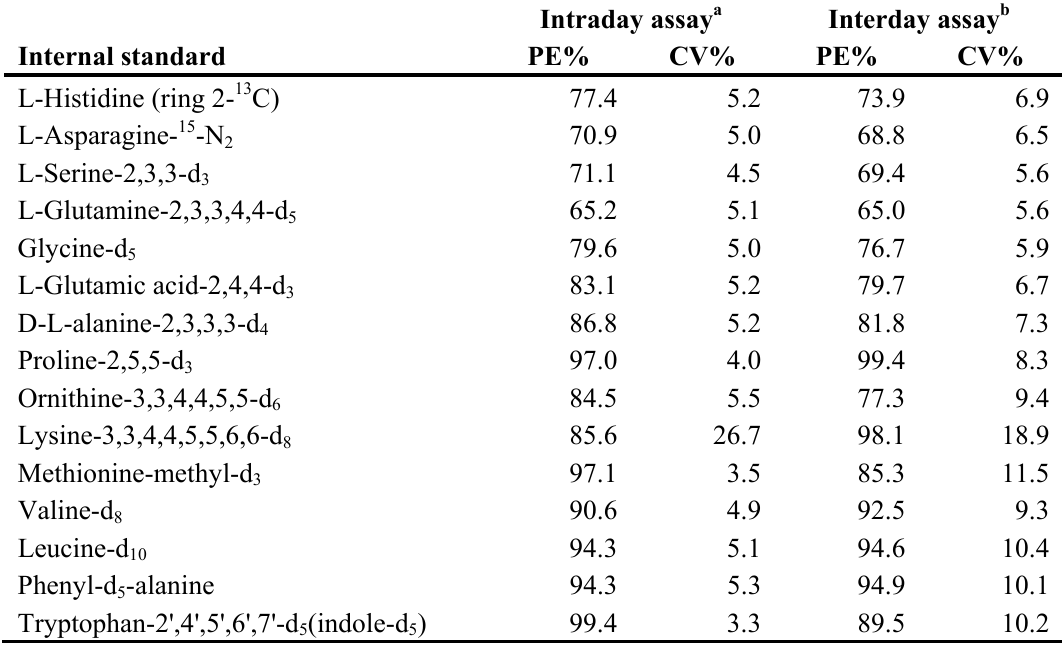
Table S4. Overall process efficiency (PE%) of the AQC derivatized internal